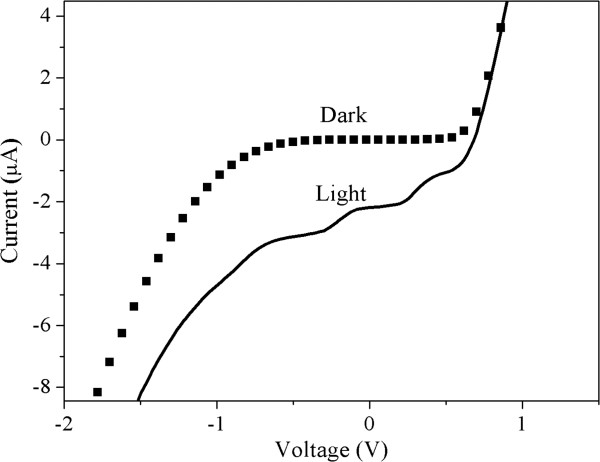
I-V results for the samples in dark and light conditions.